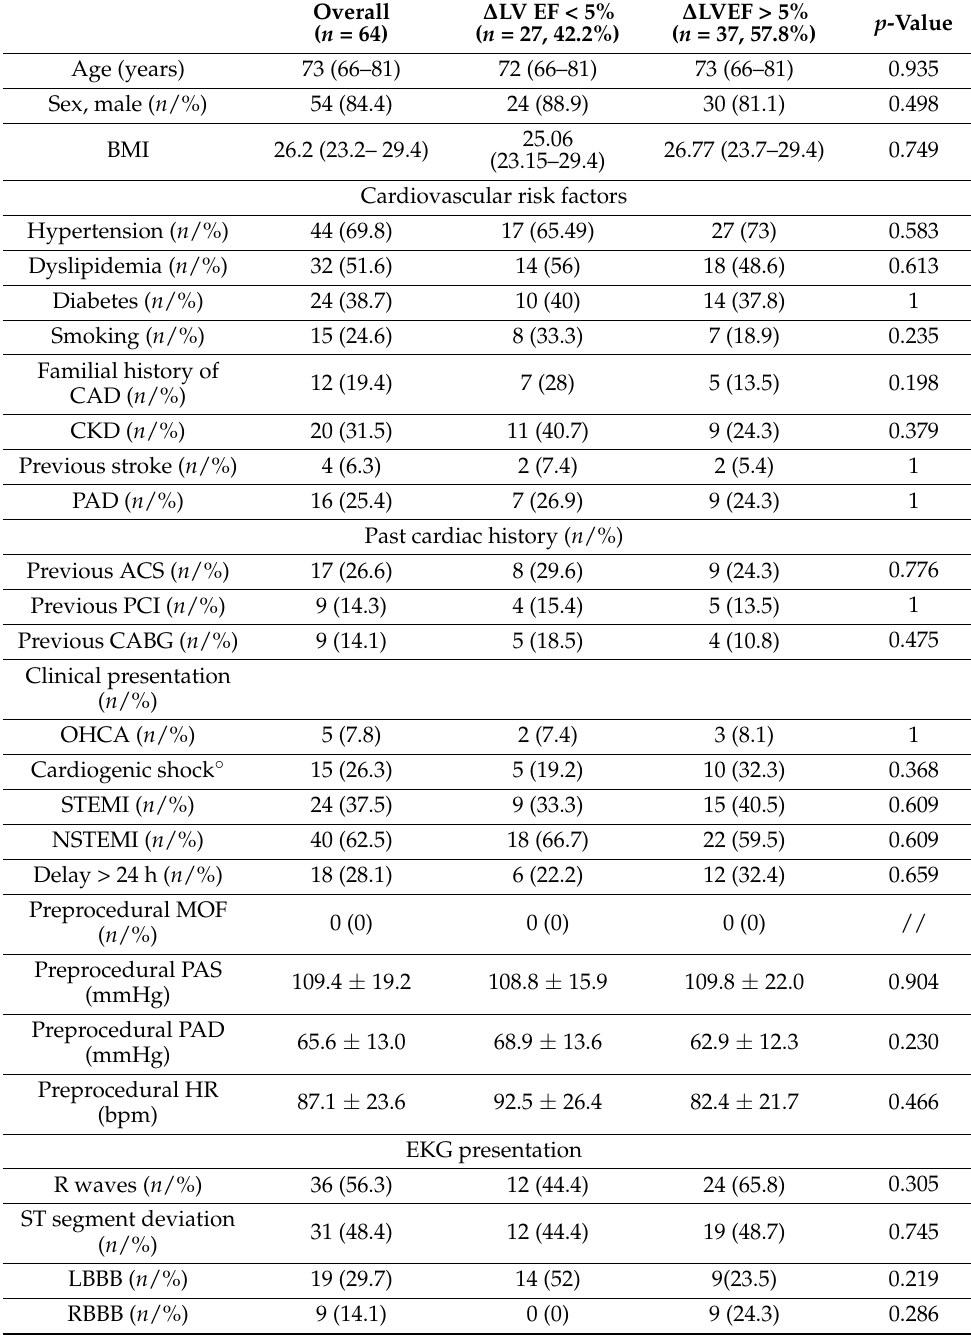
Table 1. Baseline clinical characteristics of the study